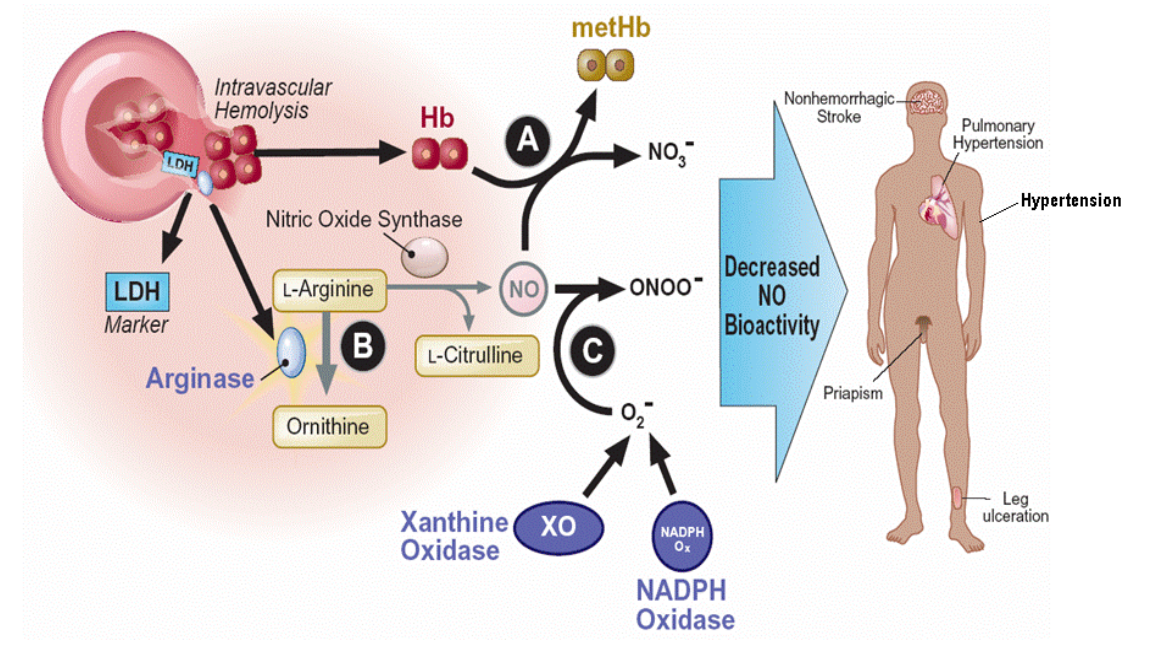
FIGURE 2. Intravascular hemolysis and NO bioactivity in sickle cell disease. Intravascular hemolysis releases hemoglobin, arginase, and LDH into the plasma. Hemoglobin inactivates NO, generating methemoglobin and inert nitrate. The NO synthases generate NO from the substrate L-arginine. Arginase consumes L-arginine. NO is also consumed by reactions with reactive oxygen species, producing oxygen radicals like peroxynitrite (ONOO-)(C). Decreased NO bioactivity in sickle cell disease is associated with pulmonary hypertension, priapism, leg ulceration, hypertension, and nonhemorrhagic stroke. (From Kato et